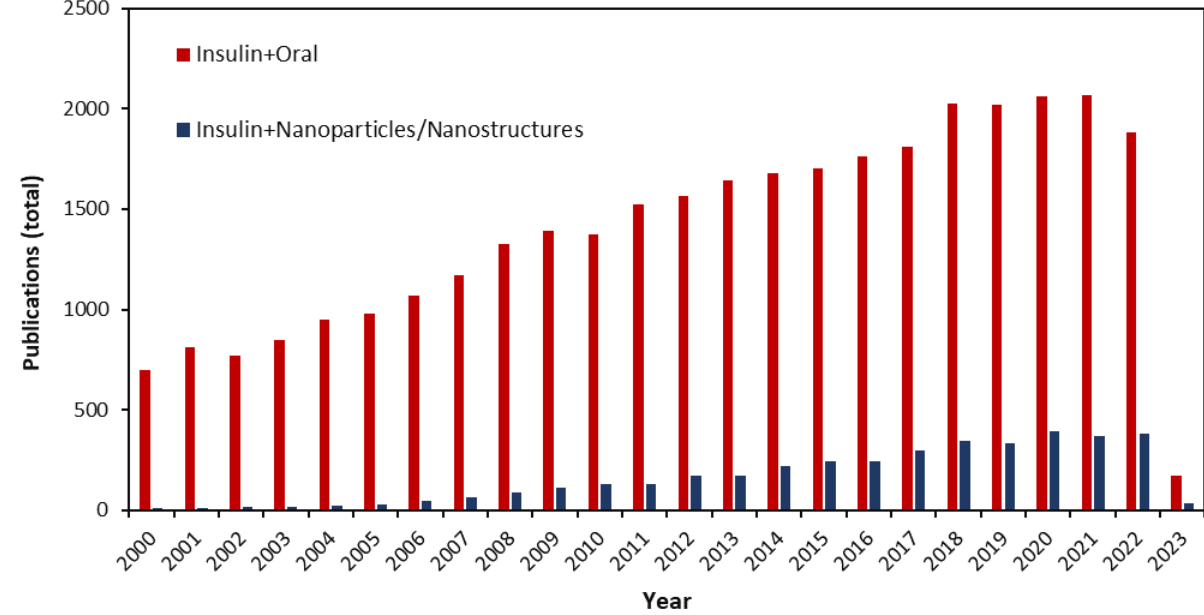
Figure 3. The number of articles published in the field of insulin drug delivery by oral administration and insulin nanoparticles/nanostructures between 2000 and 2023.